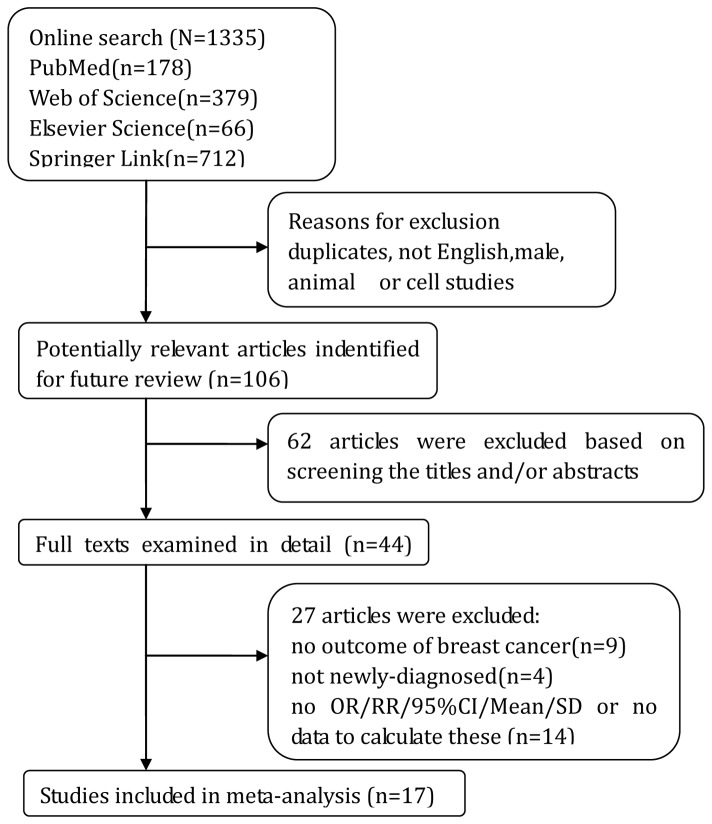
Flow diagram of the study selection process.